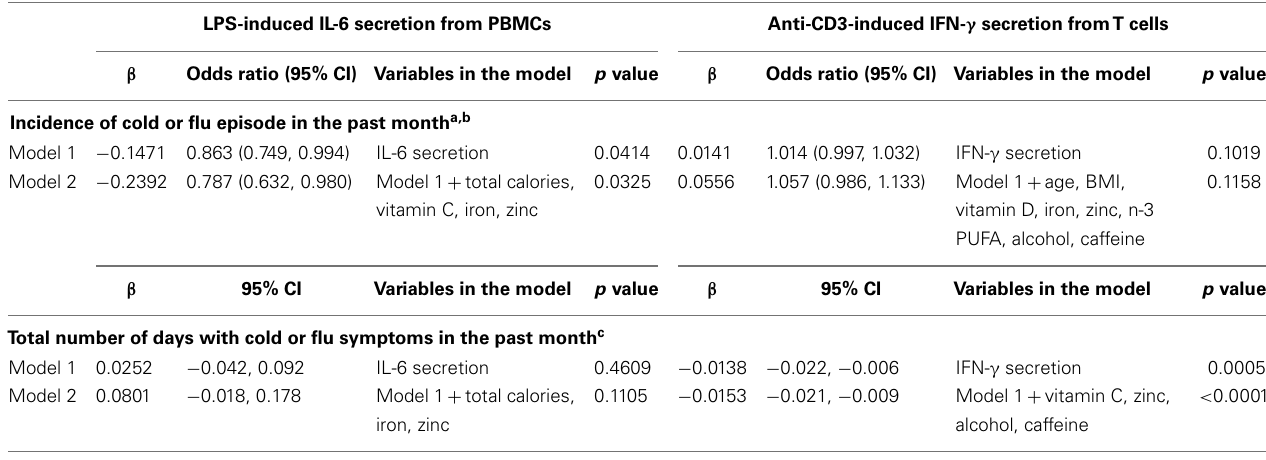
Table 4 | Cytokine secretion as predictors of self-reported cold or flu incidence and severity . LPS-induced IL-6 secretion from PBMCs Anti-CD3-induced IFN- γ secretion fromT cells β Odds ratio (95% CI) Variables in the model p value β Odds ratio (95% CI) Variables in the model p value